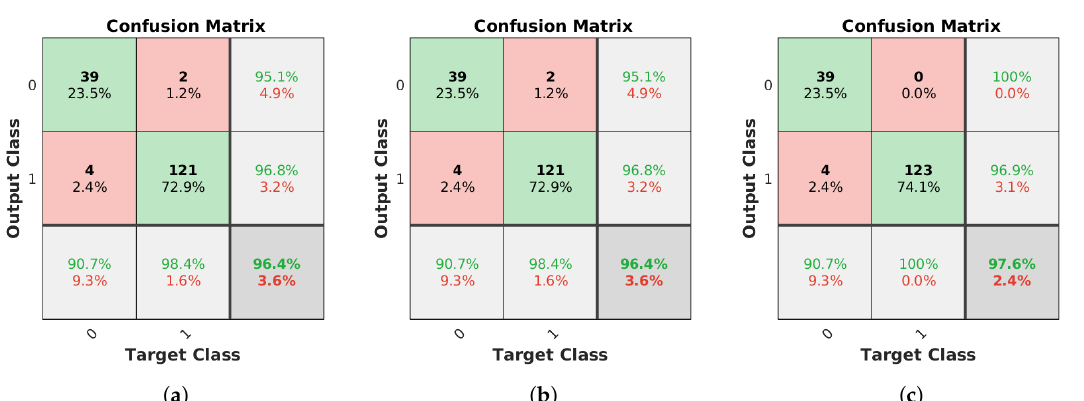
Figure 15. Confusion matrices for the lamp state, with class 0 and 1 representing the off and on state, respectively. Values in the diagonal indicate the number of correct matches for each class, while the rest of the values correspond to incorrect identifications depending on the expected and detected class. Percentages of correct and incorrect identifications are included in the last row and column.